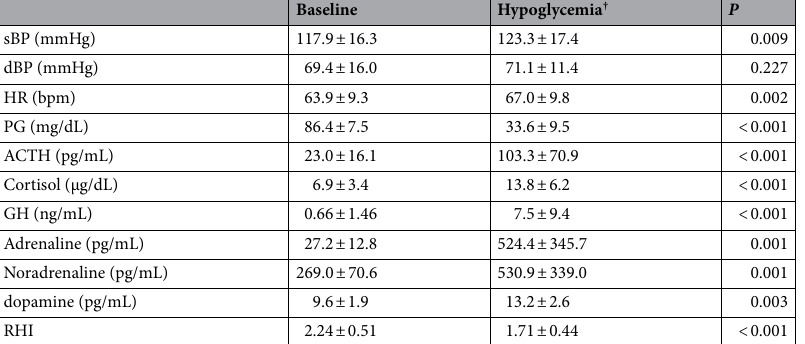
Table 2. Insulin tolerance test. Data are mean ± standard deviation. P values by Wilcoxon signed-rank test. sBP, systolic blood pressure; dBP, diastolic blood pressure; HR, heart rate. PG, plasma glucose; GH, growth hormone; ACTH, adrenocorticotropic hormone. † sBP, dBP, HR and RHI values at 120 min after insulin administration; PG, adrenaline, noradrenaline and dopamine values at hypoglycemia; ACTH, cortisol and GH values at peak during insulin tolerance test.